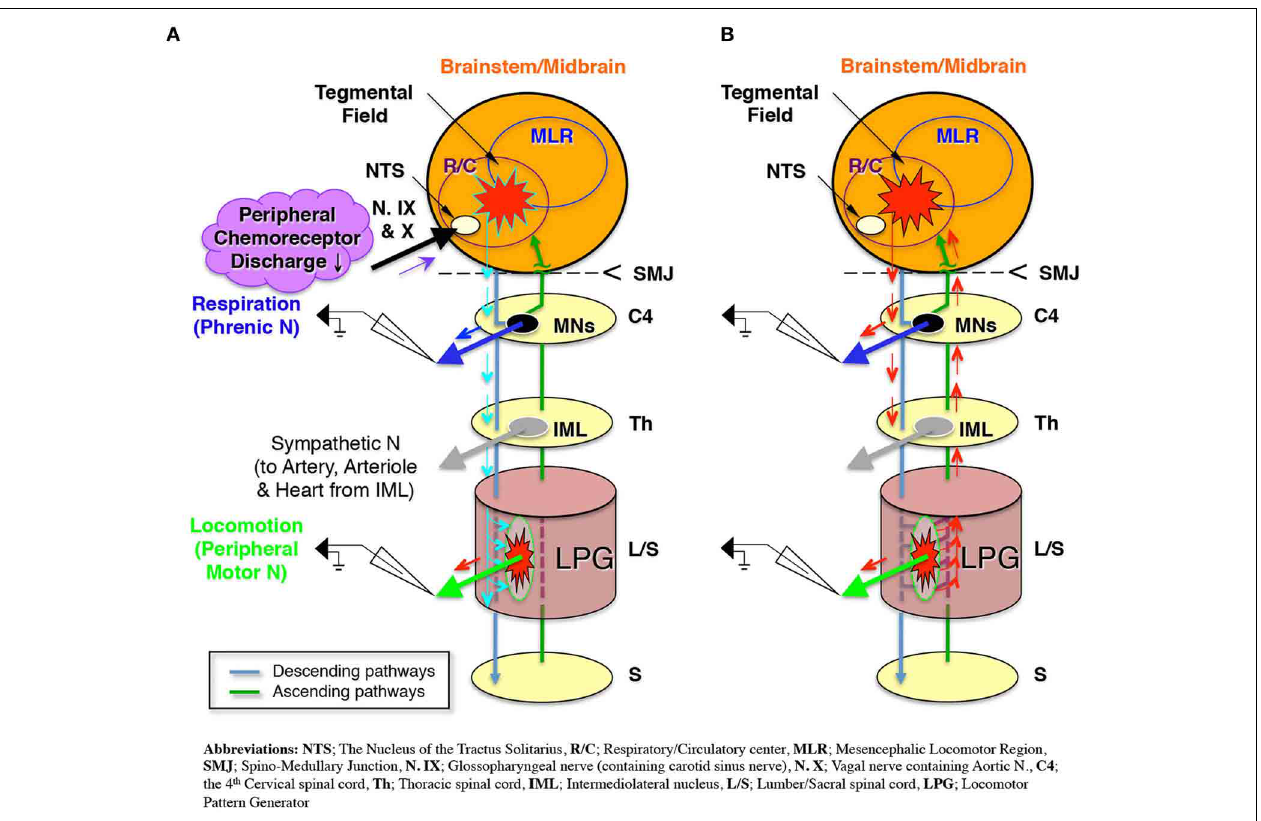
FIGURE 8 | Schematic representation of (A). The modulated sympathetic tone generating fictive locomotion via descending pathways and (B) The locomotor rhythm that entrains the respiratory rhythm via ascending pathways during